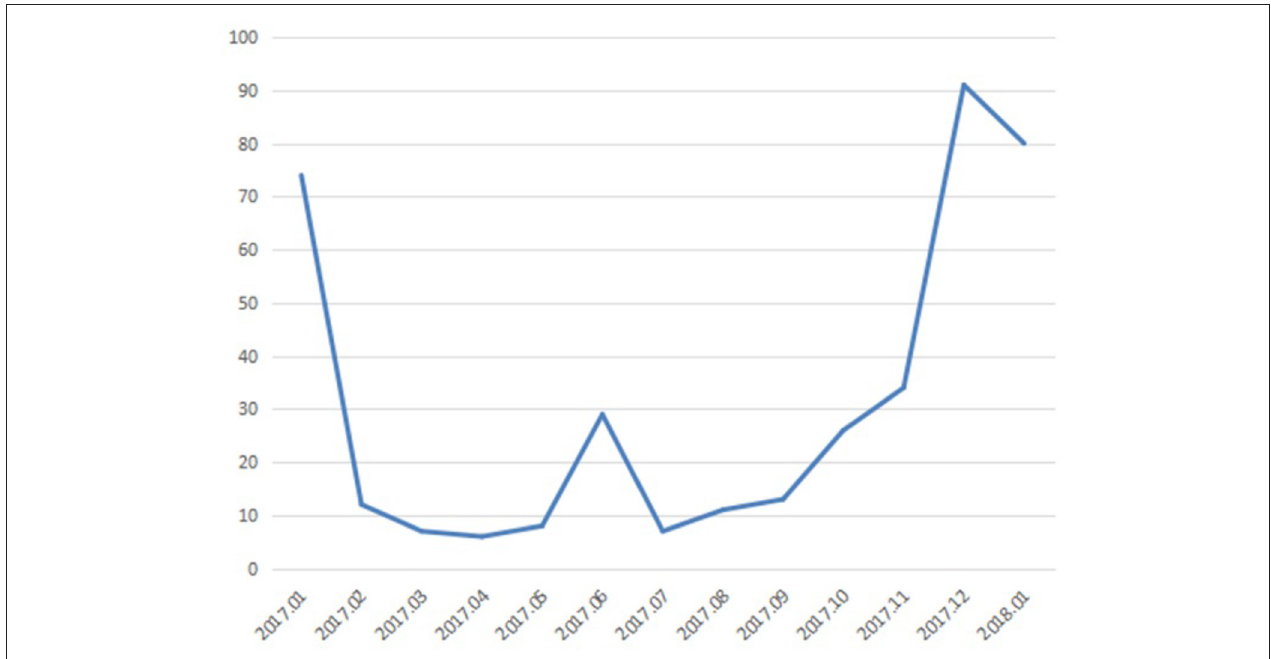
FIGURE 6 | The time series distribution diagram of the negative emotion